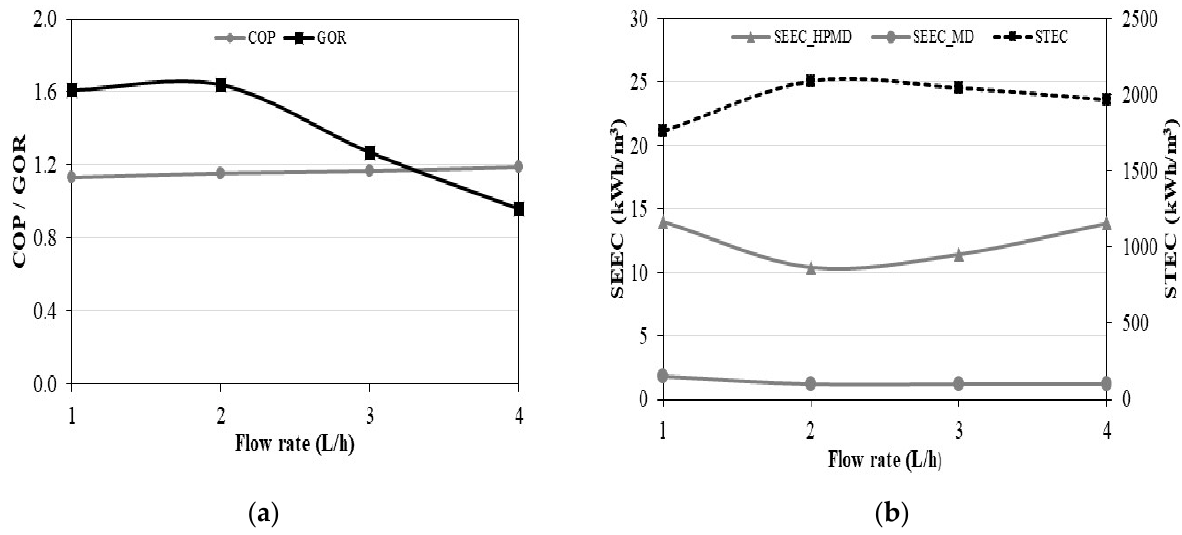
Figure 12. Effect of flow rate, on ( a ) COP and GOR, ( b ) STEC and SEEC in continuous mode.